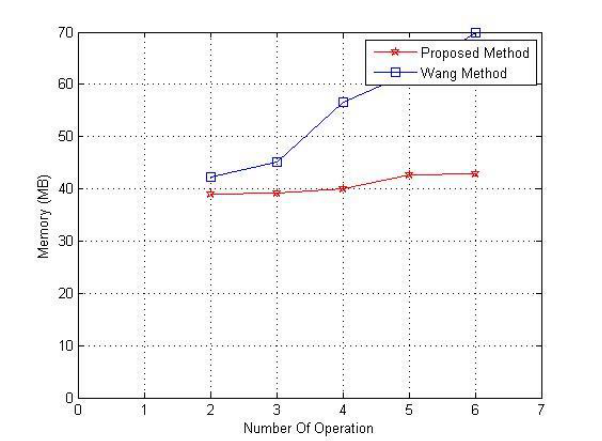
Figure 6. Comparison of memory consumption by different numbers of web services.